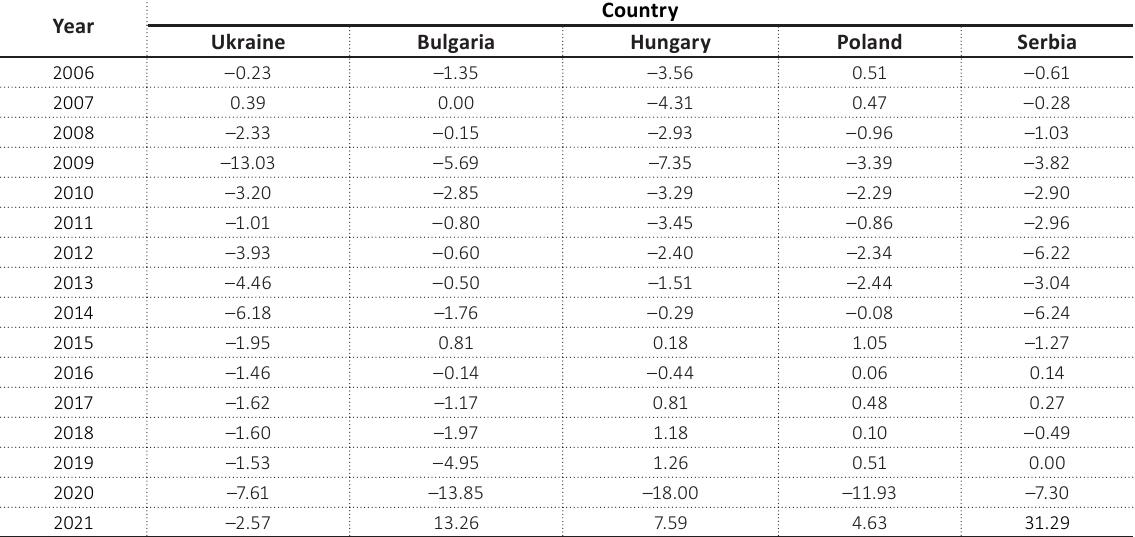
Table 1. Fiscal solvency index in Ukraine, Bulgaria, Hungary, Poland, and Serbia, 2006–2021 Source: Composed and calculated by the authors based on Tables A1, A4, A5 of Appendix